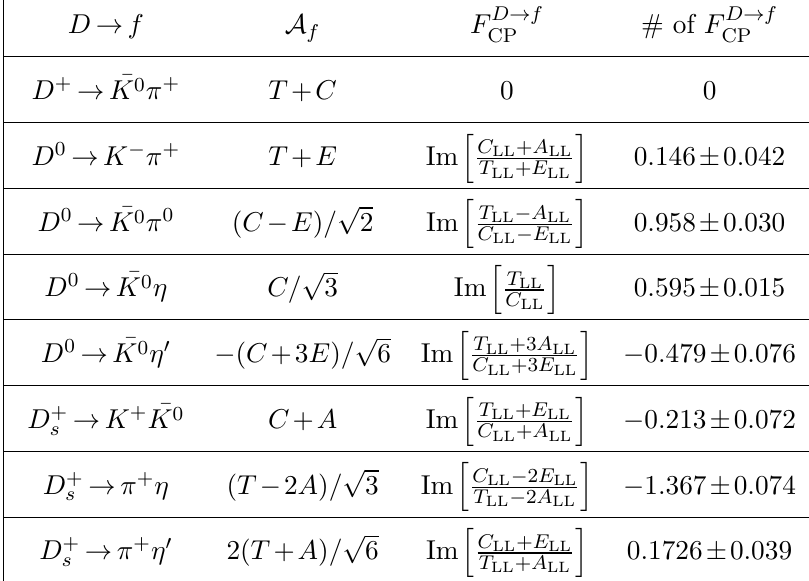
Table 2 . Diagrammatic amplitudes [12], process-dependent factors for CP asymmetry, and their numerical values for Cabibbo-favored charmed meson decays. The uncertainty comes from the 1 (cid:27) errors of the diagrammatic amplitudes. Here, we (cid:12)x the (cid:17) (cid:0) (cid:17) 0 mixing angle at arcsin(1 = 3). (which appears in eq. (2.2)) are randomly generated in the range [0 ; 2 (cid:25) ]. We observe